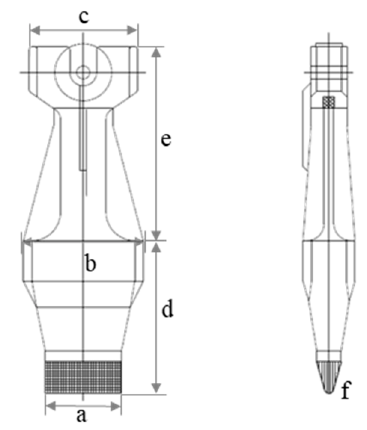
Figure 6. Description of 15-times scaled-down crusher model. Table 3. Crusher model properties.